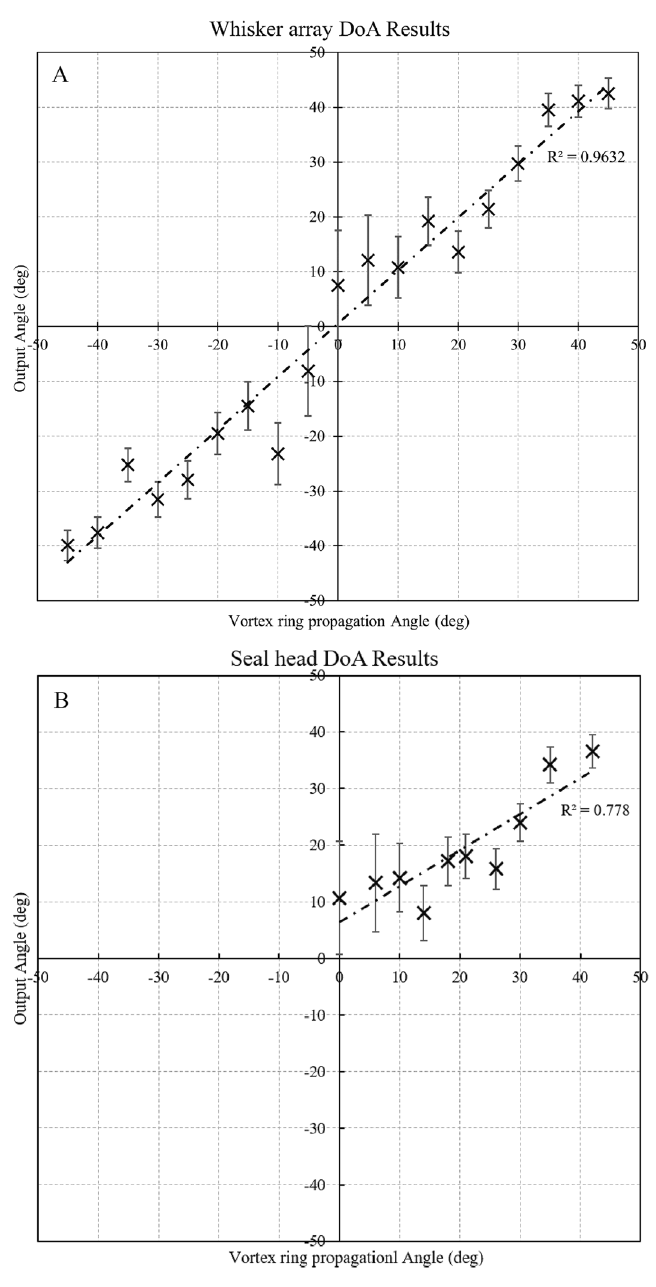
Figure 8. Calculated DoA angle using multilateration versus the vortex travel direction. Error bars indicate the range of DoA predictions produced from 50+ different whisker pairings per angle, from a single pulse. ◦ ( A ) regular array on the flat plat for a full 90 arc (Top). ( B ) array on the sea lion model tested for single-sided ◦ ◦ contralateral pad impact at angles from 0 to 45